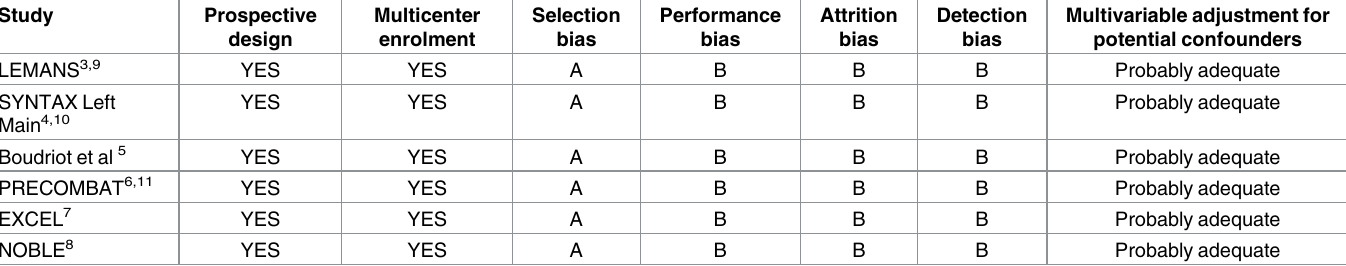
Table 5. Design featuresand appraisal of the internal validity of included studies. Risk of bias is expressedas A (low risk), B (moderate risk), C (high risk), and D (incomplete reportingleadingto inabilityto ascertain the underlyingrisk of bias).